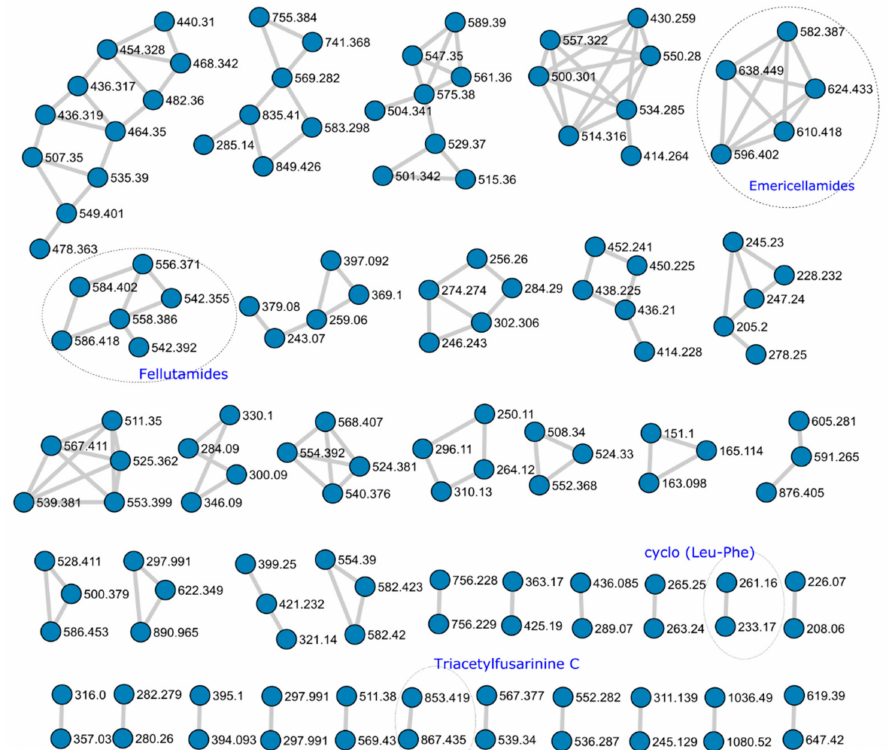
Figure2. MetabolicNetworkclusterobtainedfromtheUPLC-HRMSanalysisof Aspergilluspachycristatus mutants grown in SMY medium showing network clusters with two or more nodes. Numbers represent the HRMS m / z observed for each node. Circled clusters indicate molecules positively